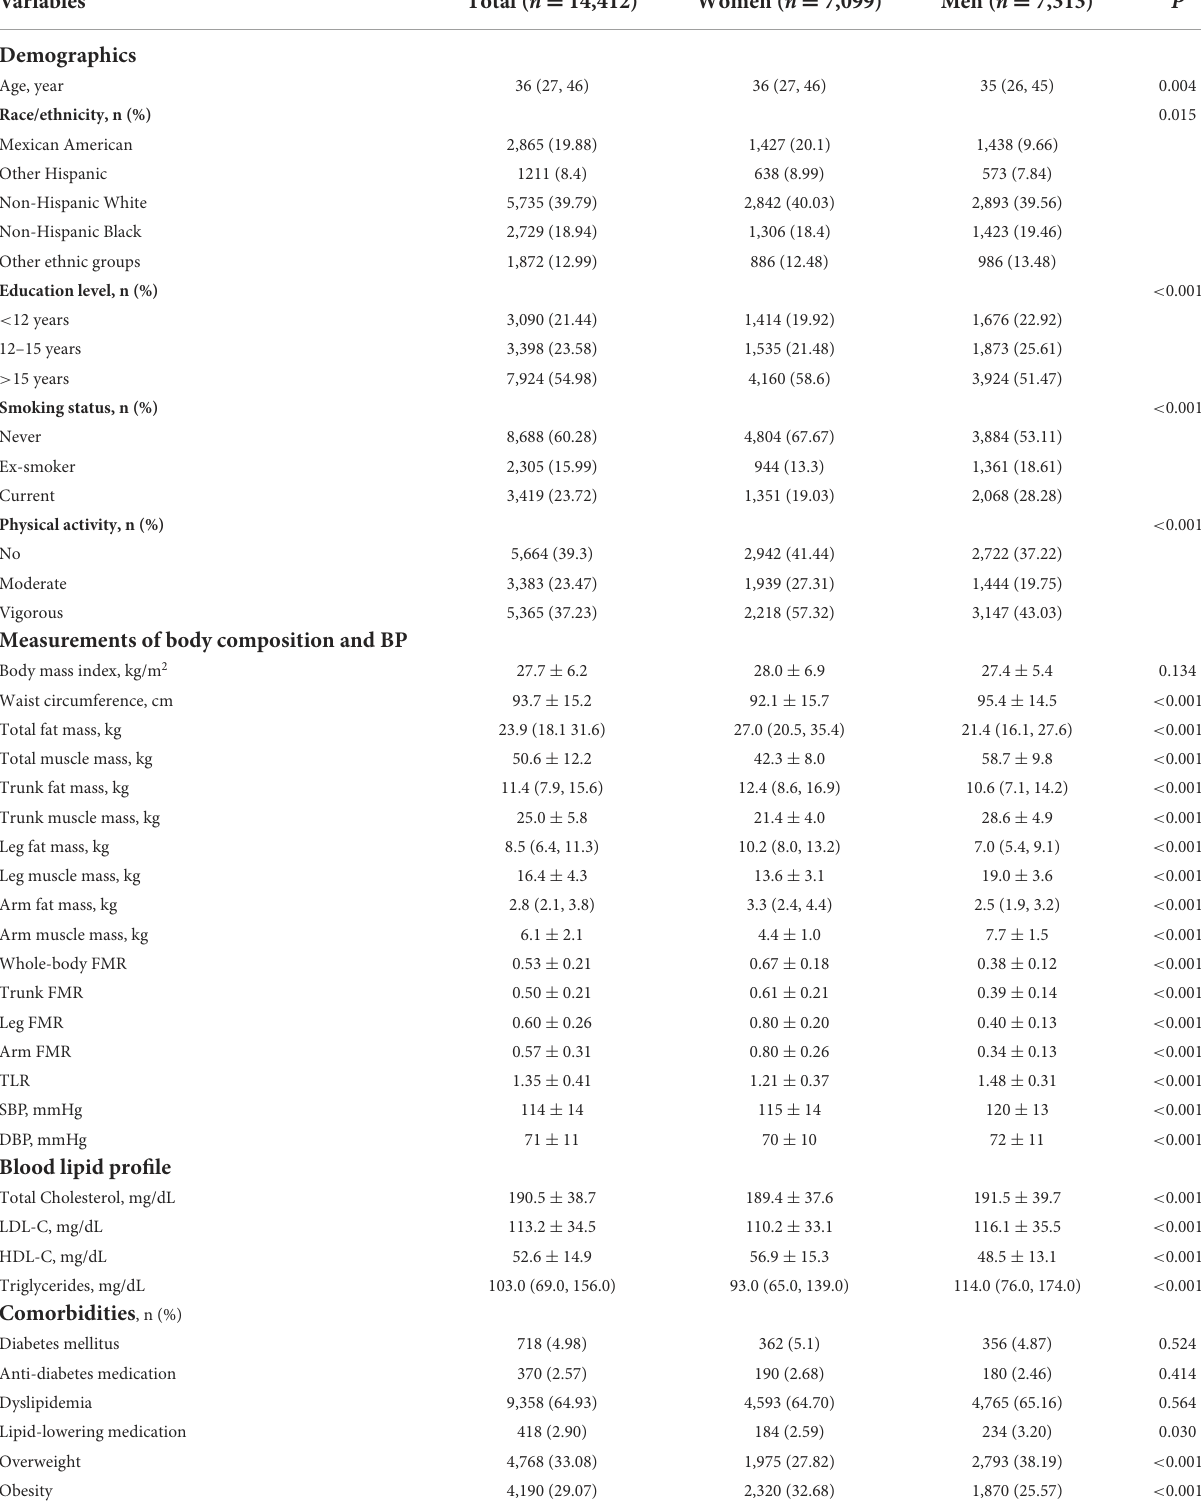
TABLE 1 Characteristics of the study